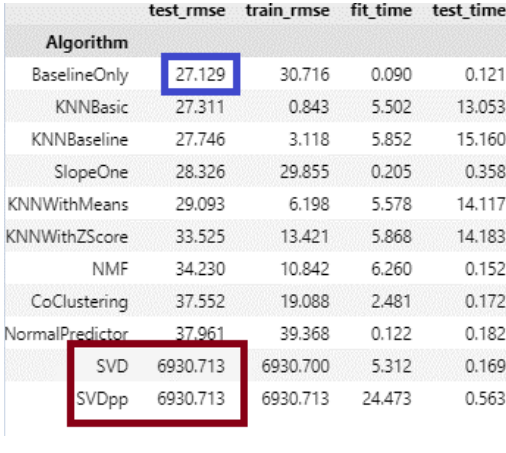
Figure 5. CV results for quantity